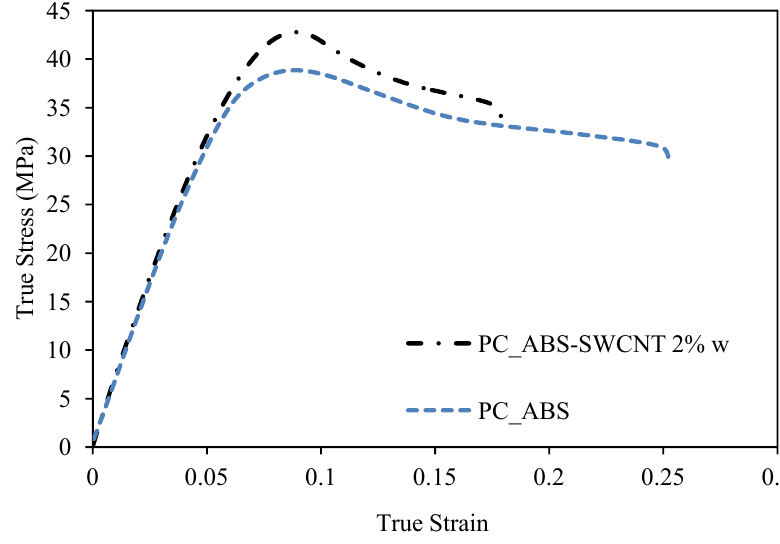
Figure 12. Collected uniaxial experimental data for PC/ABS-SWCNT composite material samples with 2% weight fraction of SWCNT at the strain rate of 0.001 s − 1